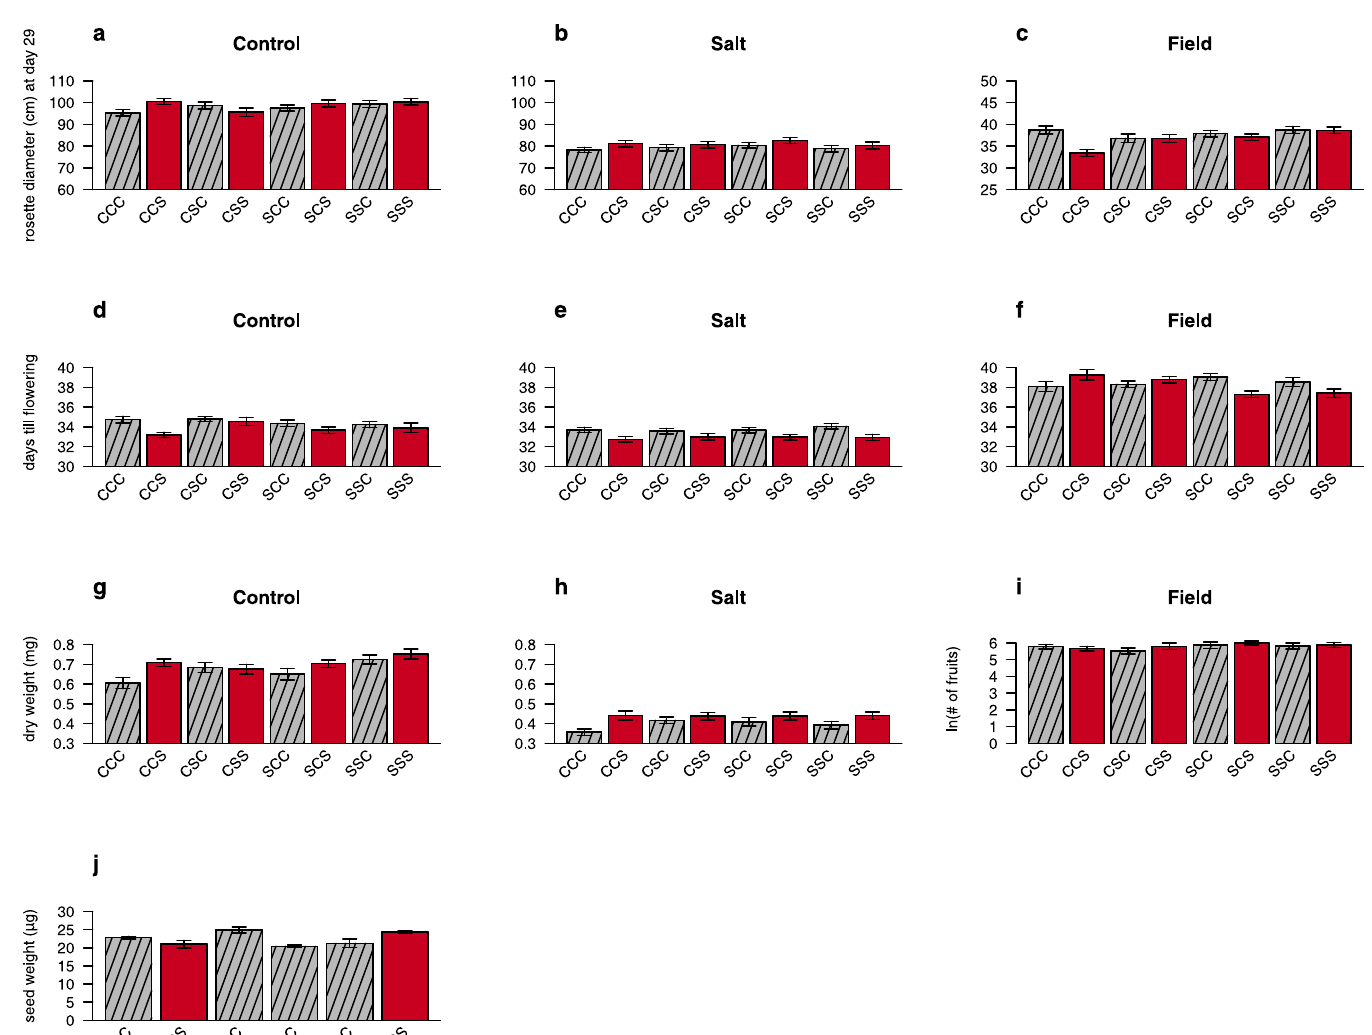
Fig 2. Expression of offspring phenotypes in three different environments after exposure of parental, grandparental and/or great-grandparental generations to salt stress. Panels a, b and c show rosette diameter (mm); panels d, e and f show flowering time (days); panels g, h, i show biomass (mg) or number of fruits (mean ± sem) for respectively climate chamber control, climate chamber salt and field environment. Panel j shows average seed weight, which only shows six experimental groups because of limited seed availability. Significant differences between groups are shown in Table 2. The striped grey bars indicate that the parents of the experimental plants were grown under control conditions. The red bars indicate that the parents of the experimental plants were grown under salt stress.